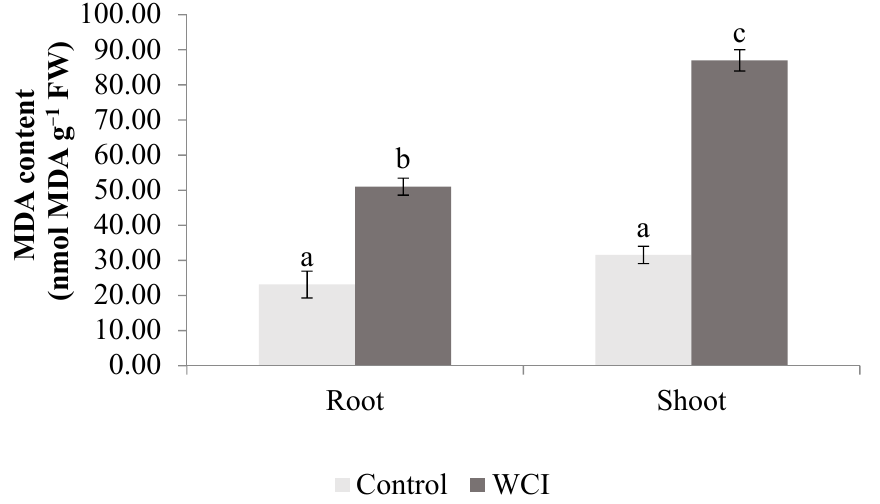
Figure 5. The effect of woolly cupgrass infestation (WCI) on the MDA content of maize 21 d.a.s. (values represent means ± SD, n = 5). Small letters (a, b, c) show significant differences between treatments based on independent t -test ( p < 0.05).